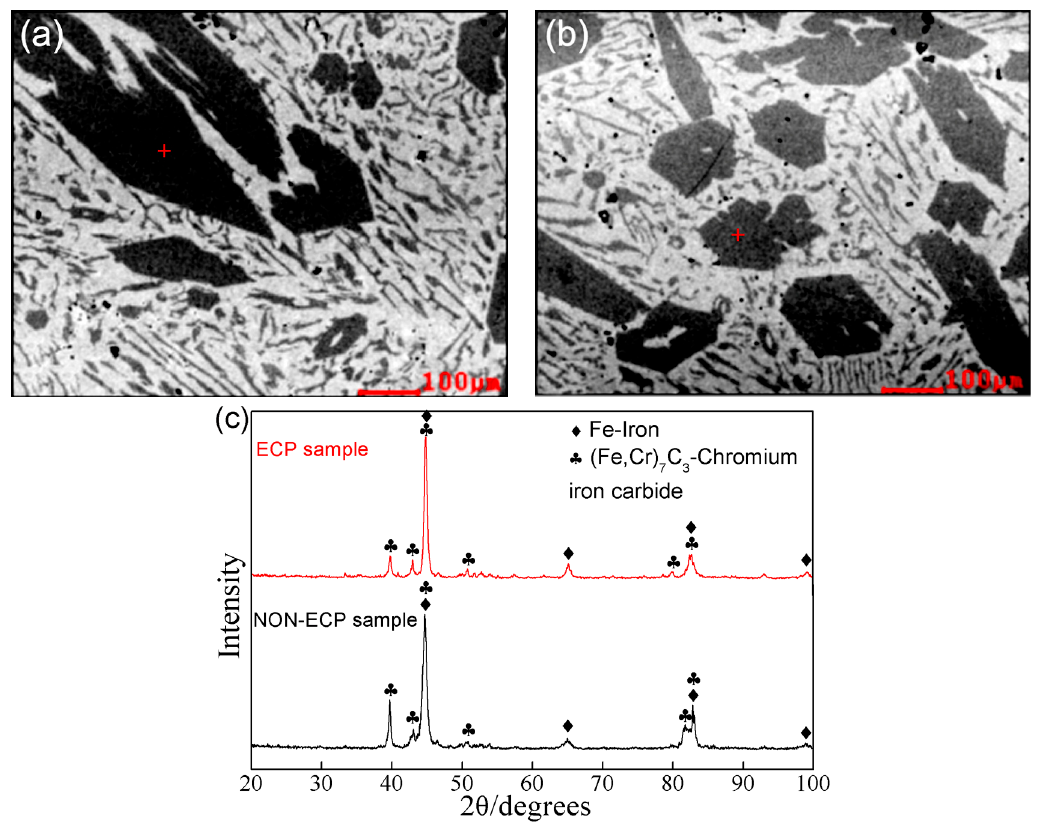
Figure 4. Phase analysis of the primary carbides by EPMA and XRD. The EPMA location on the primary carbides in the ( a ) non-ECP sample and ( b ) ECP sample. ( c ) Typical XRD patterns of the non-ECP sample and ECP sample. Table 2. Composition of the primary carbides in hypereutectic high chromium cast iron. Element C (at%) Cr (at%) Fe